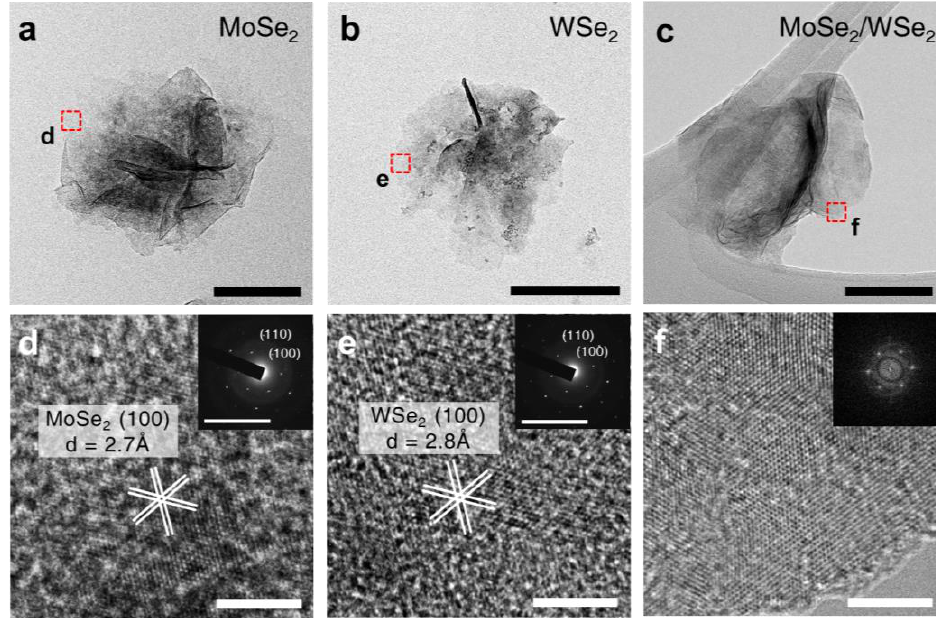
Figure 2. ( a – c ) Low-magnification bright field TEM images of ( a ) MoSe 2 , ( b ) WSe 2 , and ( c ) MoSe 2 /WSe 2 hetero-nanosheets. Scale bars: ( a , b ) 200 nm and ( c ) 300 nm. ( d – f ) HRTEM images corresponding to the regions highlighted by dashed red boxes shown in ( a – c ) Scale bars: ( d , e ) 5 nm and ( f ) 20 nm. Insets in ( d – f ) correspond to the SAED and FFT patterns. Scale bars, 100 nm −1 .